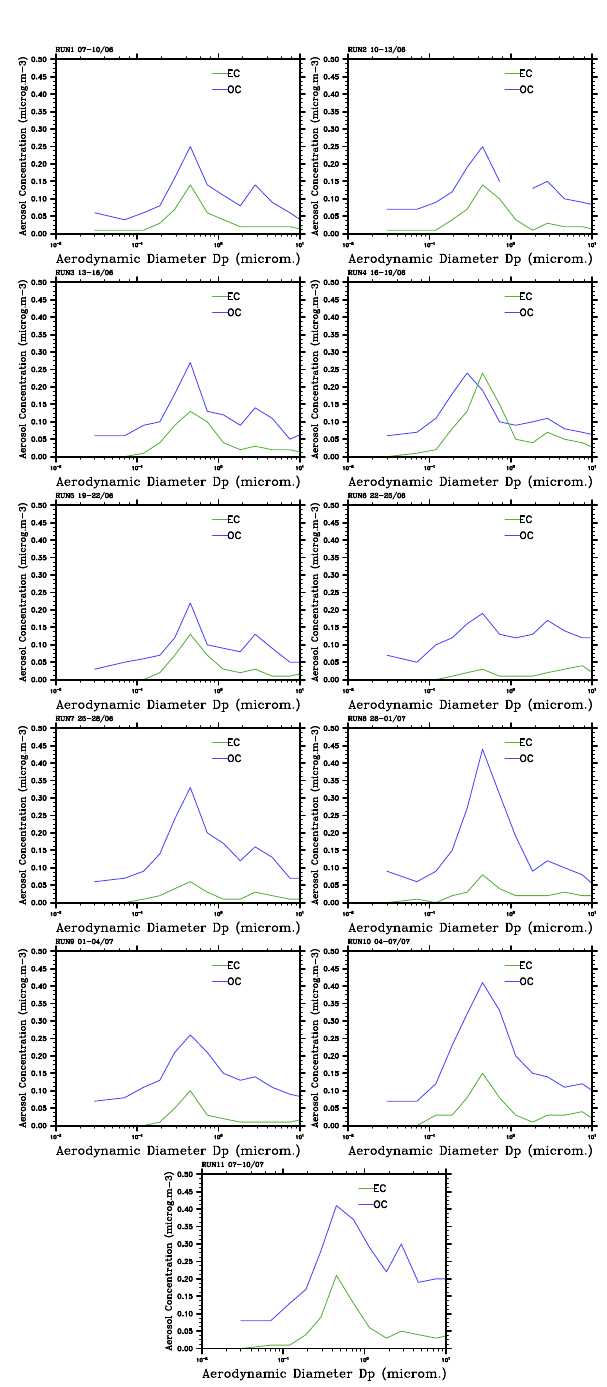
Figure 16. EC and OC (48h mean) aerosol mass size distributions obtained at Ersa from the DEKATI impactor instrument for the en- tire SOP-1a